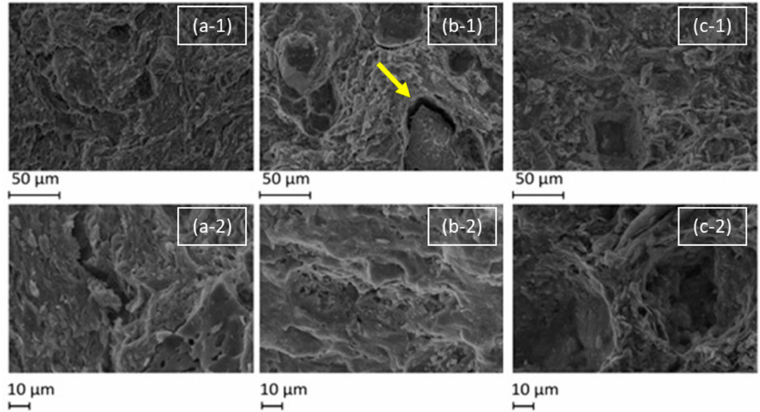
Figure 8. SEM micrographs of the surface of test ceramics: brown ( a ), red ( b ) and white ( c ) under magnifications of 500 (-1) and 1000 (-2) times. The yellow arrow points to a visible